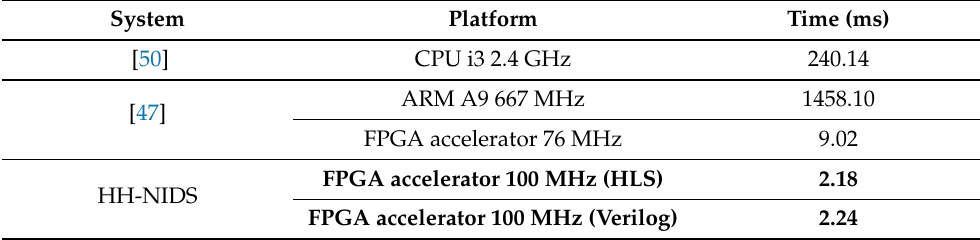
Table 11. Comparison in inference time on different platforms and between related